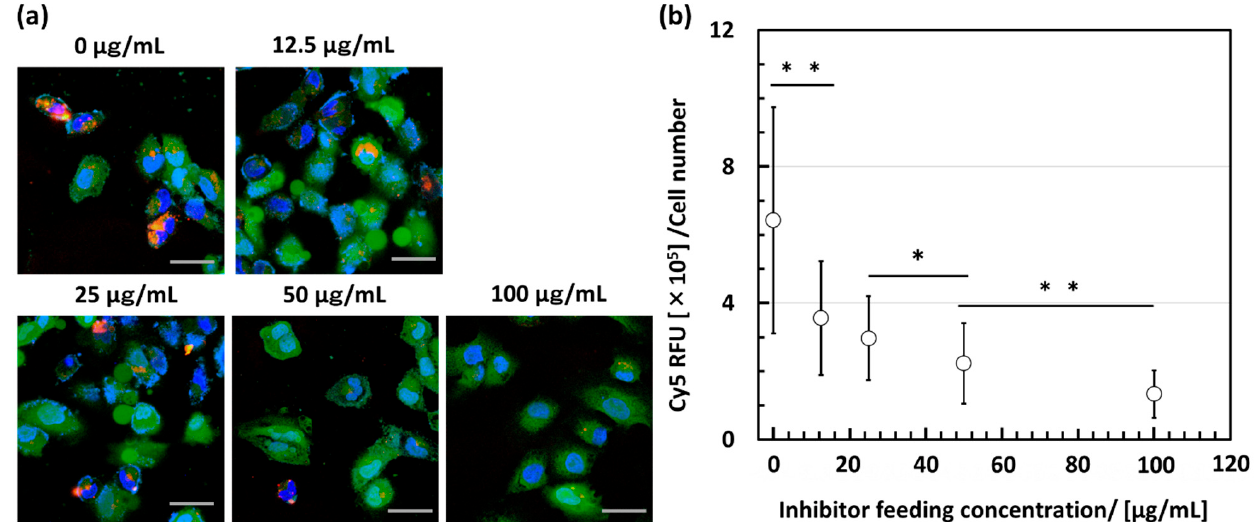
Figure 3. Inhibition assay conducted to validate the targeting ability of DBCO-CD276Ab. DAOY cells were incubated with both CD276Ab and DBCO-CD276Ab-Cy5. ( a ) CLSM images of DAOY cells incubated with DBCO-CD276Ab-Cy5 under inhibitor concentrations of 0, 12.5, 25, 50, and 100 μ g/mL. Fluorescence derived from Hoechst 33258 counterstain (blue), GFP (green), and DBCO-CD276Ab-Cy5 (red) were observed to determine whether the antibodies could successfully target the CD276-expressing DAOY cells. The scale bar indicates 50 µ m. ( b ) Quantitative analysis of Cy5-derived fluorescence observed within cells, conducted by measuring the brightness of each cell using ImageJ. For statistical analysis, a Student’s t -test followed by Bonferroni correction for multiple comparison was conducted. A significant difference is represented by * p < 0.05 and ** p < 0.01. Data are shown in average ± standard deviation.